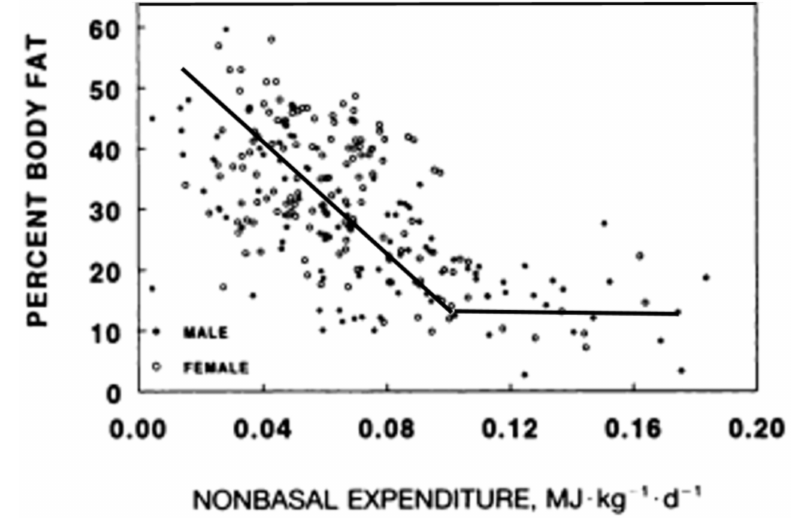
Figure 2. The inverse relationship between metabolic energy expenditure other than resting metabolism and the level of body fat. Modified from Rising, Harper, Fontvielle, Ferraro, Spraul, Ravusin. Determinants of total daily energy expenditure variability in physical activity. Am J Clin Nutr 1994, 59, 800–804, doi:10.1093/ajcn/59.4.800 [21], and Schulz, Schoeller. A compilation of total daily energy expenditure and body weights in healthy adults. Am. J. Clin. Nutr. 1994, 60, 676–681, doi:10.1093/ajcn/60.5.676